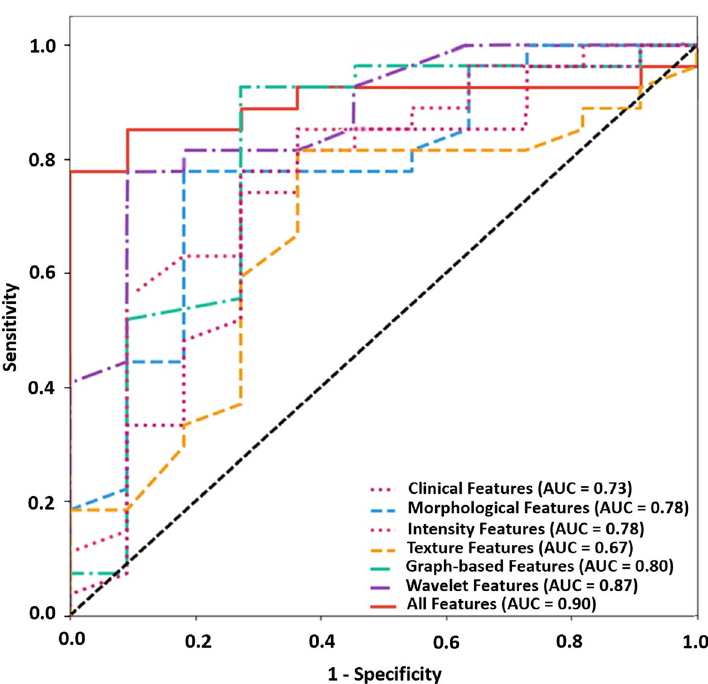
Figure 4. Receiver operating characteristic (ROC) curves on the independent test set for the predictive models developed with the selected features obtained in different experiments. In the last experiment and from all feature subsets, 7 wavelet and graph-based features were